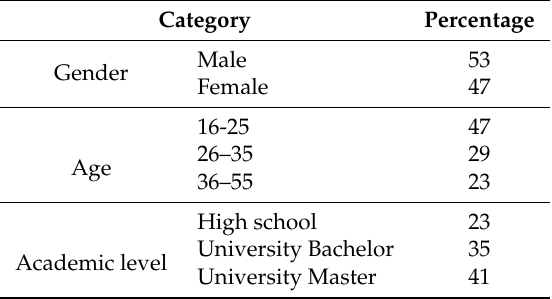
Table 6. Demographic profile of actual